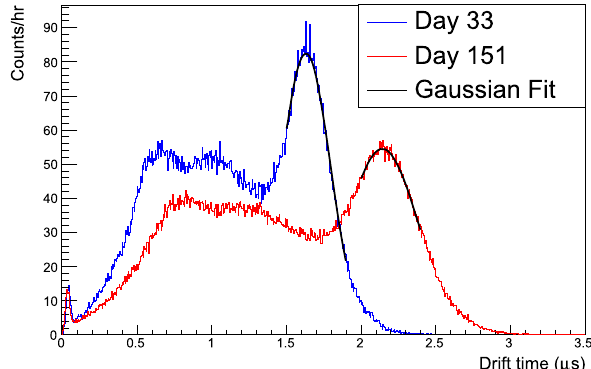
Fig. 18 The drift time distribution for all events with energies between 1 and 6MeV during two data sets with the source incident at r = − 4 . 5mm, taken after 33 days of data-taking (in blue) and 151 days of data-taking (in red). The peak of (bulk) long drift-time events is fit with a Gaussian (in black) to study the drift time stability over time. The small peak seen at drift times less than 100ns is due to the α